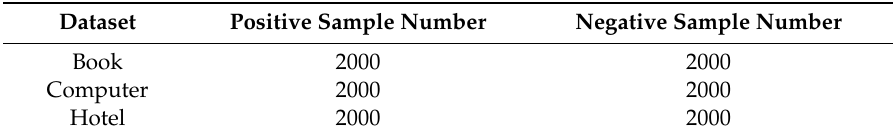
Table 1. Chinese experimental dataset.